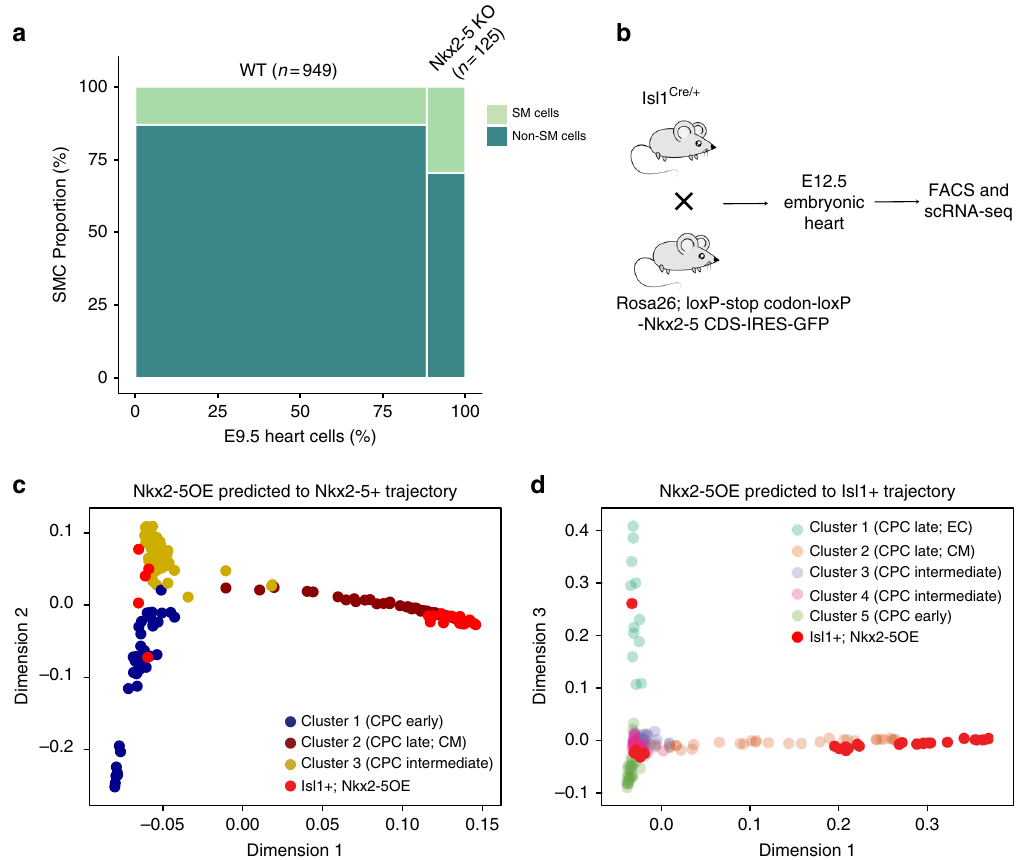
Fig. 6 Nkx2-5 institutes a unidirectional fate in CPCs to cardiomyocytes. a Re-analysis of published data showing the ratio of smooth muscle cells in embryonic hearts of wild type and Nkx2-5 knockout embryos at E9.5. Smooth muscle cells are scored by low expression of Nkx2-5 (LogTPM< 1, null expression) and high expression of smooth muscle cell genes ( Tagln, Cnn1, Acta2, Cald1, Mylk, Hexim1, and Smtnl2 moderate to high (LogTPM> 2) for at least 5 of these 7 genes). χ 2 test: p < 2.37e − 6. n indicates cells numbers. b Schematic illustration of forced expression of Nkx2-5 in Isl1 + cells and